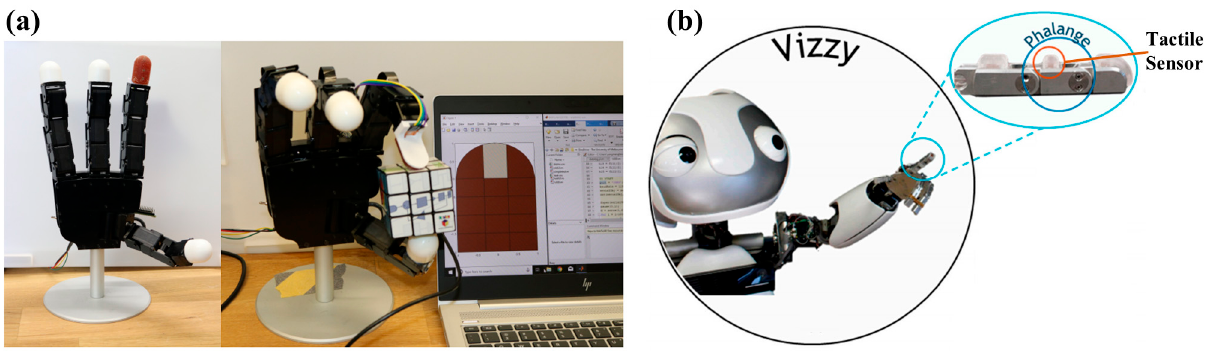
Figure 14. ( a ) Manipulator with magnetic tactile sensors designed by Alireza Mohammadi. Reprinted with permission from Ref. [81]. Copyright 2019, MDPI; ( b ) Manipulator with magnetic tactile sensors designed by Miguel Neto. Reprinted with permission from Ref. [69]. Copyright 2021, MDPI.